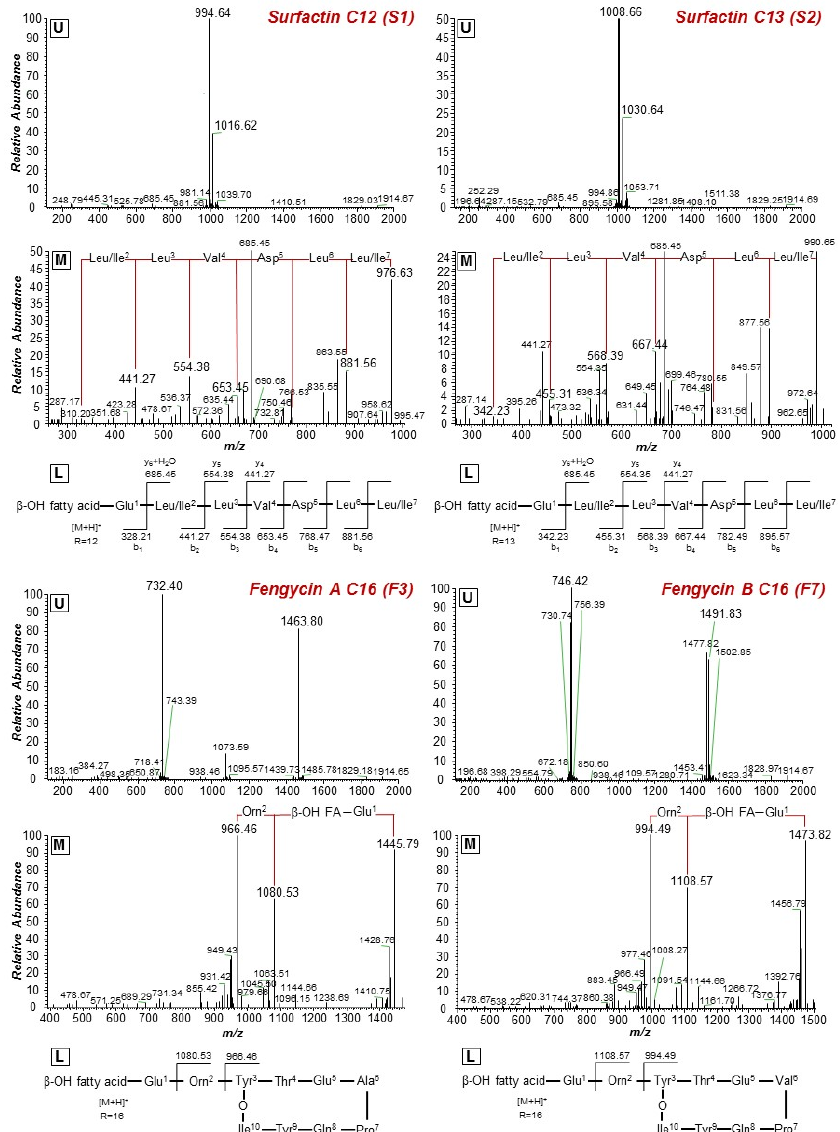
Figure 3. MS 1 ( upper plots; U ) and MS 2 ( middle plots; M ) of the annotated Bacillus sp. PTA13 lipopeptides (LP) surfactins C12 and C13, and fengycins A C16 and B C16. The fragmentation patterns were used for the identification of the LP ( lower plots; L ).